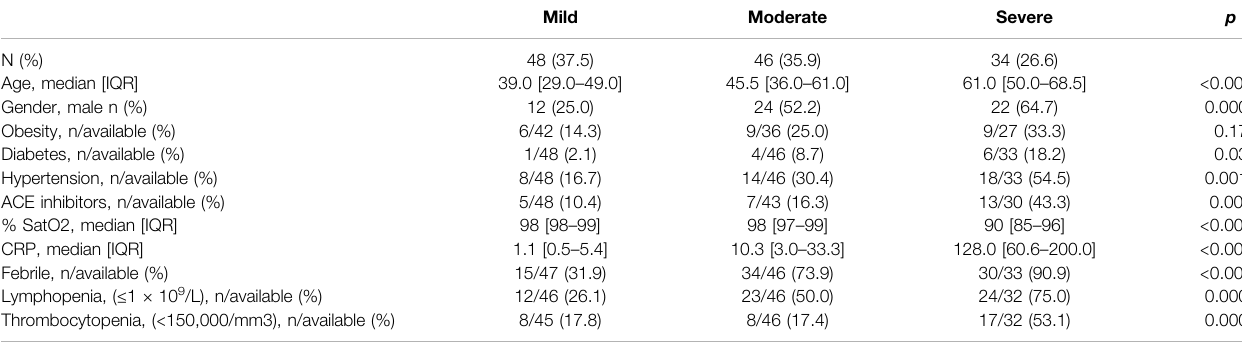
TABLE 1 | COVID-19 patients ’ demographic and clinical data.